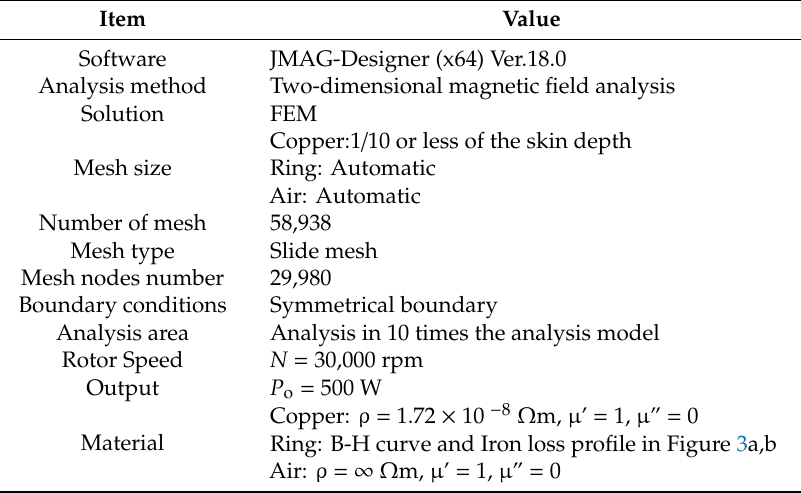
Table 3. Analysis conditions.